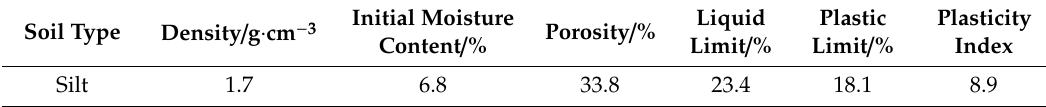
Table 1. Basic physical properties of the soil